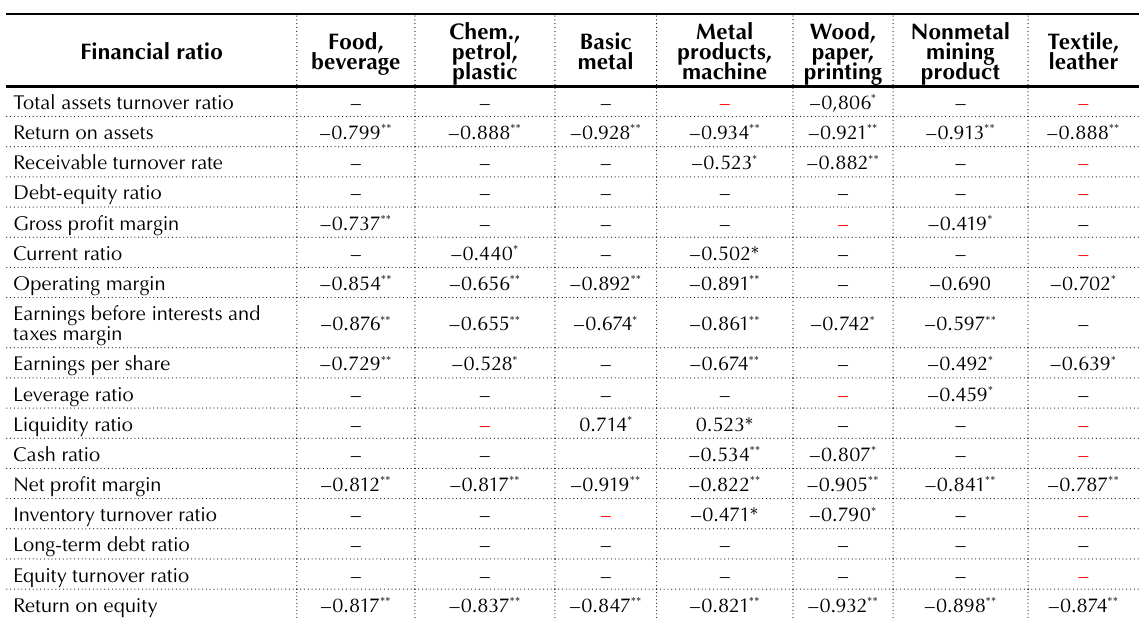
Table 6. The correlation between I 2 -distance and variables in respect of